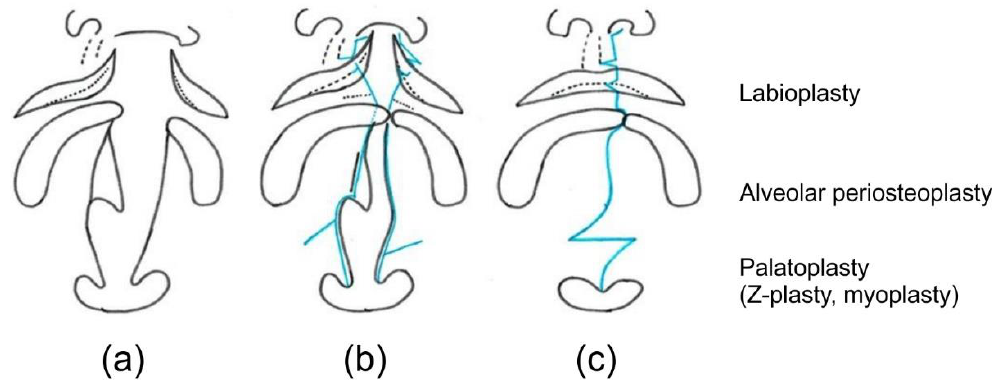
Figure 2. Schematic diagram of the single-stage surgery. ( a ) Unilateral cleft lip and palate, ( b ) incisions, and ( c ) completion of surgery.